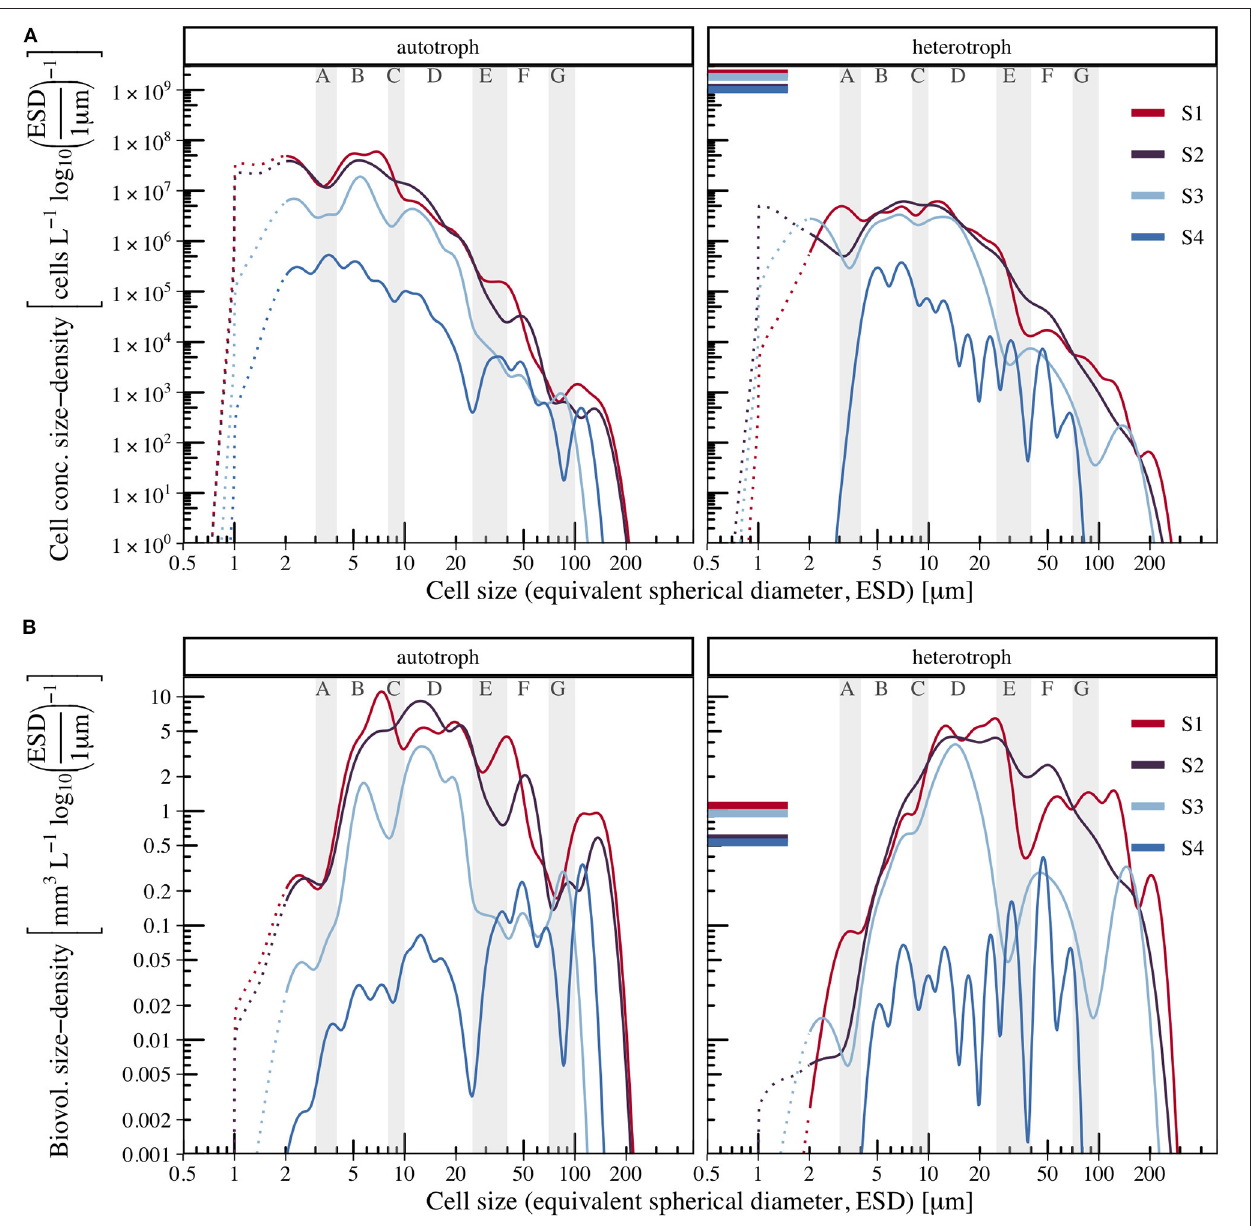
FIGURE 8 | Spectra at different times relative to the progression of plankton succession (S1–S4). During the summer cruises, the Atlantic waters were subject to bloom conditions (S1 0 weeks after bloom), while in the Polar waters the peak bloom had already passed (S2 1–8 weeks after bloom). The spatio-temporal ≈ ≈ separation of the autumn spectra was done likewise (S3 9–11, and S4 15–17 weeks after bloom). Abundance spectra are shown in (A) , biovolume spectra in (B) . ≈ ≈ Dotted lines indicate reduced reliability of size measurements for cells with ESD < 2 µ m. For comparison, abundance and biovolume concentration densities derived from Flow Cytometry cell count measurements are shown for bacteria as horizontal lines (0.5–1.5 µ m, assuming mean ESD 1 µ m, data from corresponding = samples in von Jackowski et al. (2020).